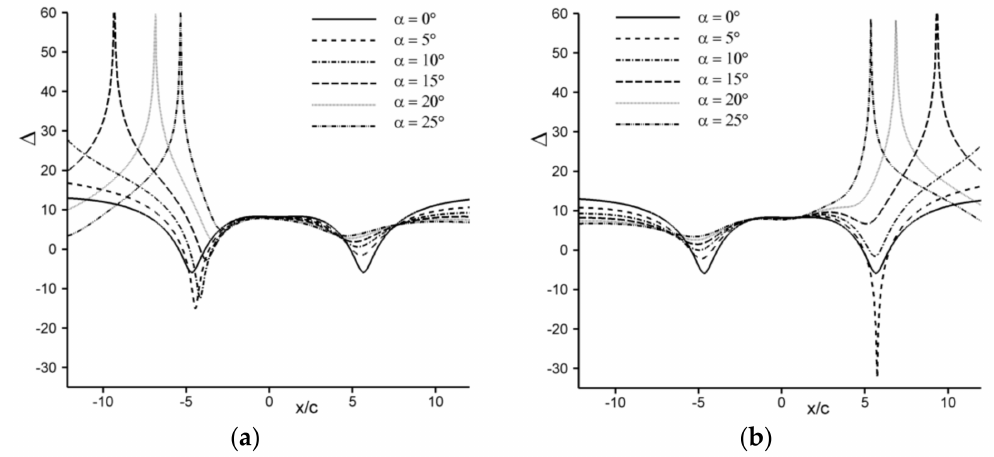
Figure 7. Low frequency ( St = 0.294) noise radiation from the trailing edge of an airfoil set at low to high incidences ( α = 0 ◦ , 5 ◦ , 10 ◦ , 15 ◦ , 20 ◦ , 25 ◦ ). Deltas (in dB) between the incident and total RMS pressure fields, as along the top ( a ) and bottom ( b )